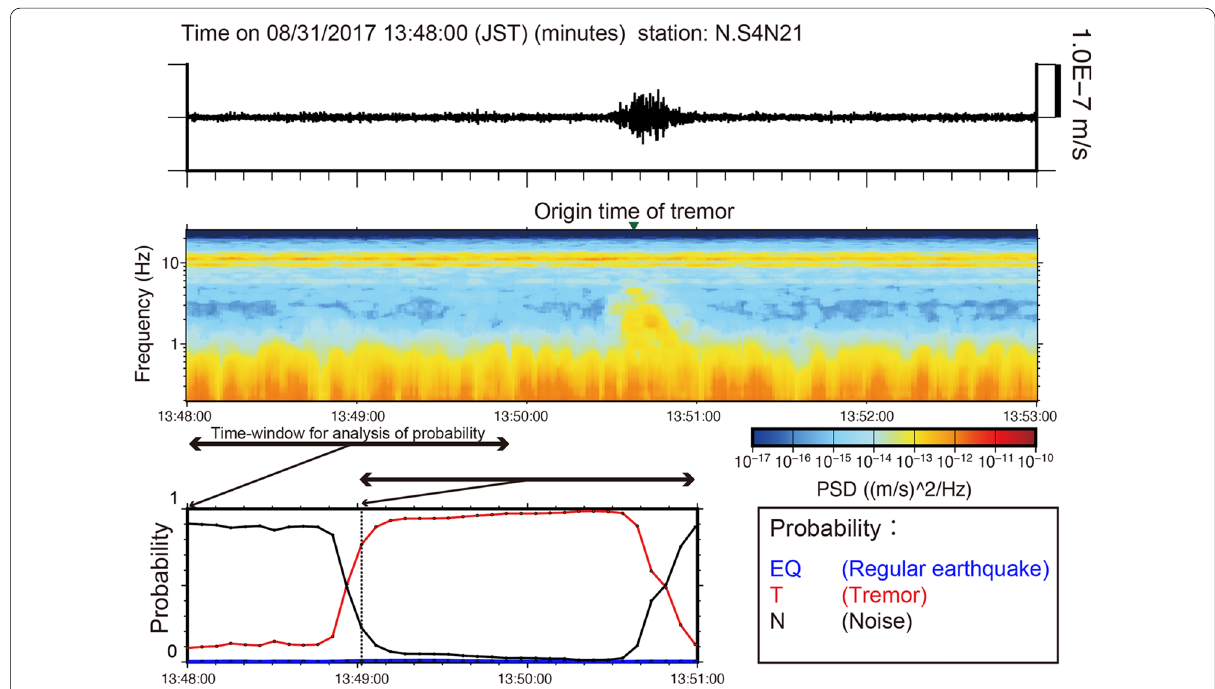
Fig. 5 Probabilities of classification of continuous seismograms. (Top) 5-min seismograms of X component. (Middle) 5-min spectrogram containing the occurrence time of tremor (Green inverted triangle; Nishikawa et al. 2019). (Bottom) Classification results corresponding to the spectrograms calculated by our CNN-based methods. Arrows indicate the time-length of each image. We calculated probabilities based on the corresponding 117.76 s time-length (arrow) with 5.12 s